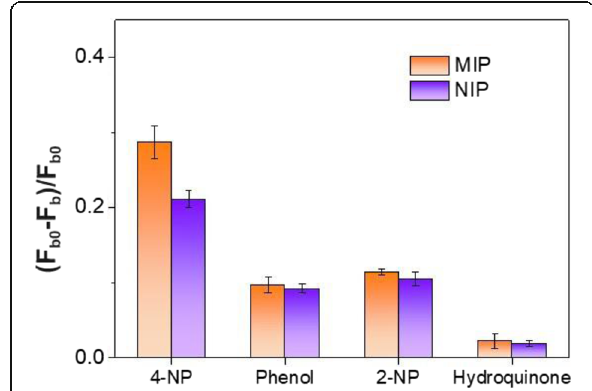
Fig. 3 The selectivity of the prepared ratiometric fluorescent probe. Fluorescence responses of the CdSe@SiO 2 /CD/MIP and CdSe@SiO 2 / CD/NIP nanohybrids towards 4.8 μ g/mL solutions of 4-NP, phenol, 2-NP (2-nitrophenol), and